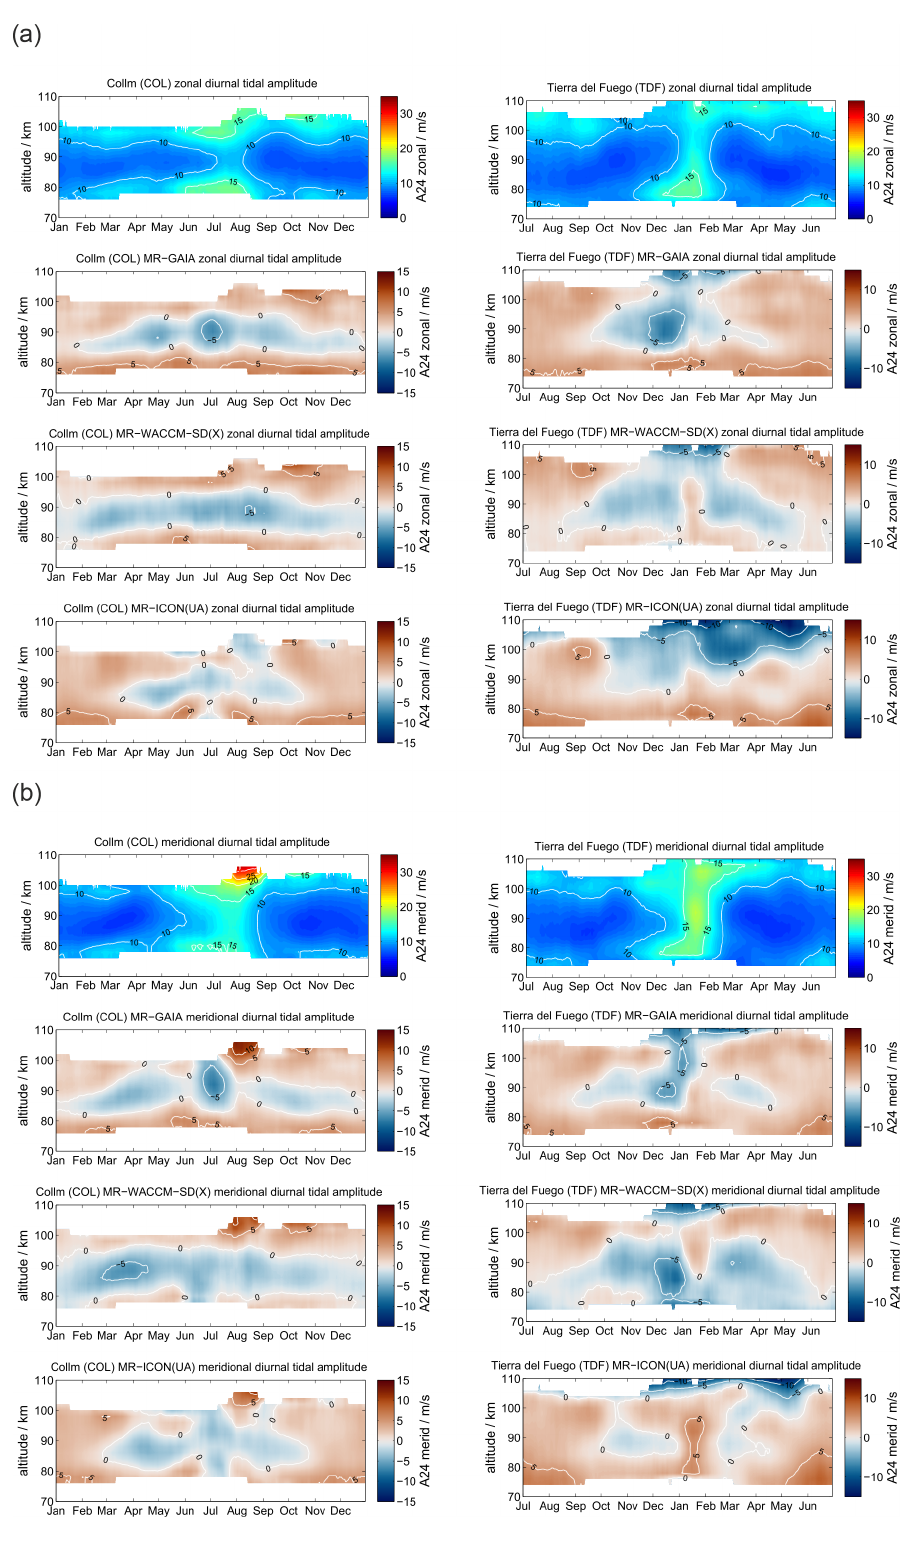
Figure C2. The same as Fig. C1, but for COL and